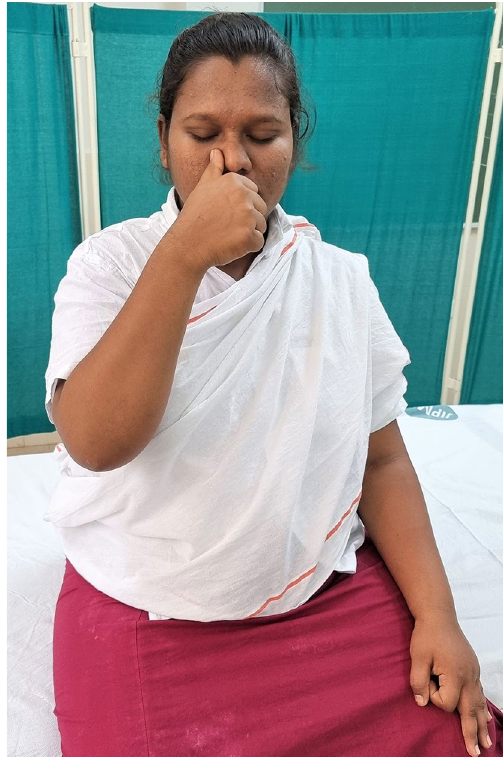
Figure 12. Chandranadi or left-nostril pranayama.